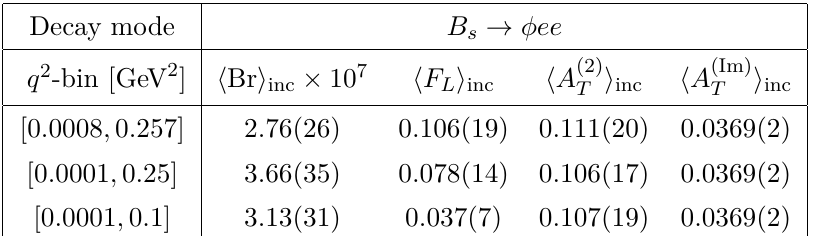
Table 1 . SM predictions for B s → φee observables in the low- q 2 region. Note that the branching fraction corresponds to the sum of Br( B